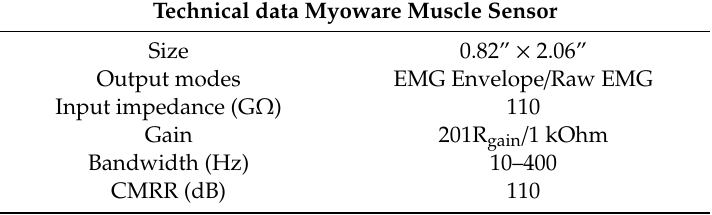
Table 3. Technical data of the Myoware Muscle Sensor (AT-04-001). CMRR (Common Mode Rejection